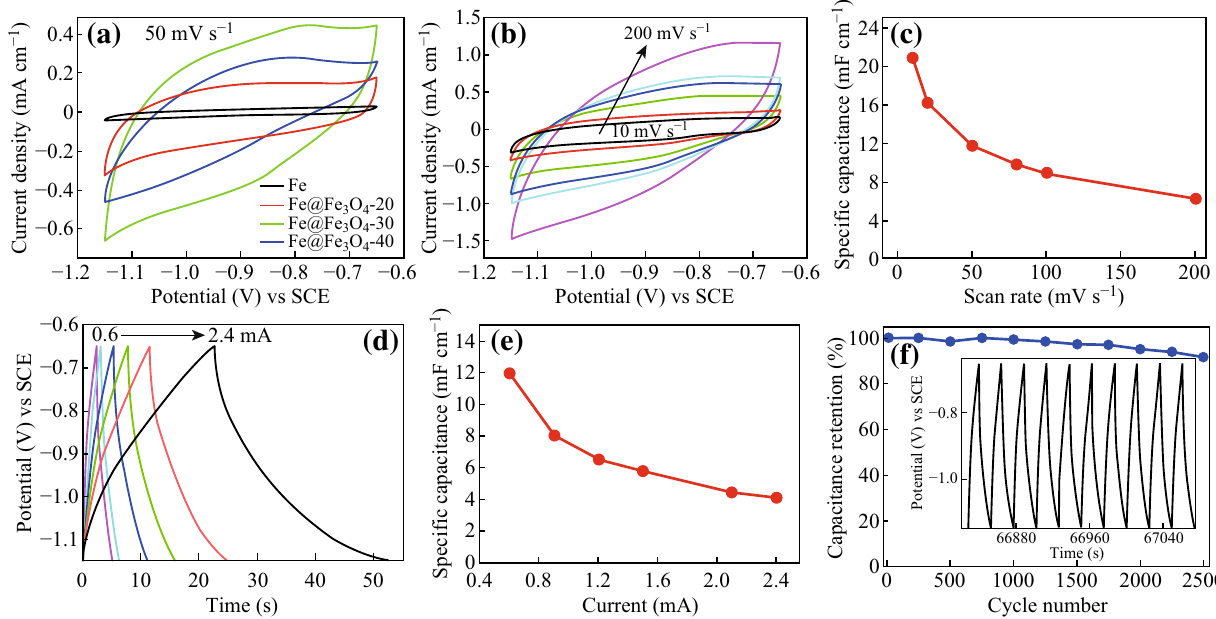
Fig. 4 a CV curves of Fe, Fe@Fe 3 O 4 -20, Fe@Fe 3 O 4 -30 and Fe@Fe 3 O 4 -40 at the scan rate of 50 mV s - 1 in 3.0 M LiCl. b CV curves of the Fe@Fe 3 O 4 -30 electrode at different scan rates. c Specific capacitances of the Fe@Fe 3 O 4 -30 electrode as a function of scan rate. d GCD curves of the Fe@Fe 3 O 4 -30 electrode at different current densities. e Specific capacitances of Fe@Fe 3 O 4 -30 as a function of current. f Cycling stability of the Fe@Fe 3 O 4 -30 electrode at a current of 0.9 mA. Inset is the last 10 charge/discharge profile of Fe@Fe 3 O 4